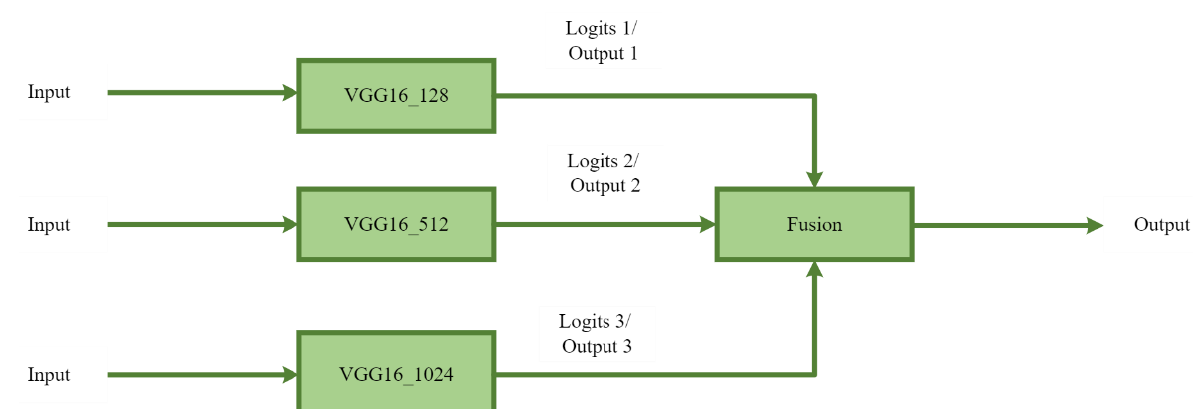
Figure 3. Fusion of dis-similar models.